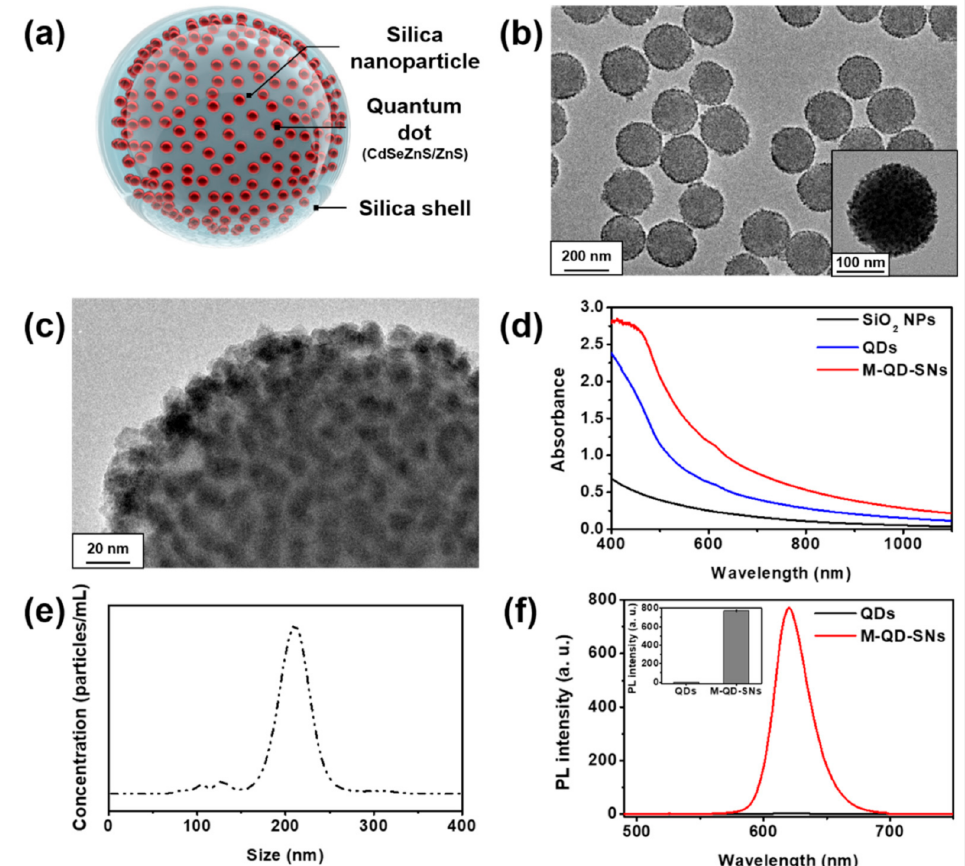
Figure 1. Characterization of silica coated multi-quantum dot (M–QD–SNs). ( a ) Schematic rep- resentation, and ( b ) transmission electron microscopy (TEM) image of M–QD–SNs. ( c ) Surface of M–QD–SNs. ( d ) UV/vis extinction spectra of silica NPs, QDots, and M–QD–SNs. ( e ) Size distribution of M–QD–SNs. ( f ) Comparison of PL intensity at 532 nm excitation wavelength between single QDots and M–QD–SNs (inset: comparison of max